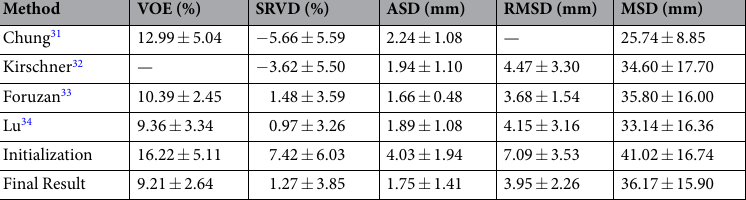
Table 2. The quantitative comparative results for the 3Dircadb1 dataset as mean and standard